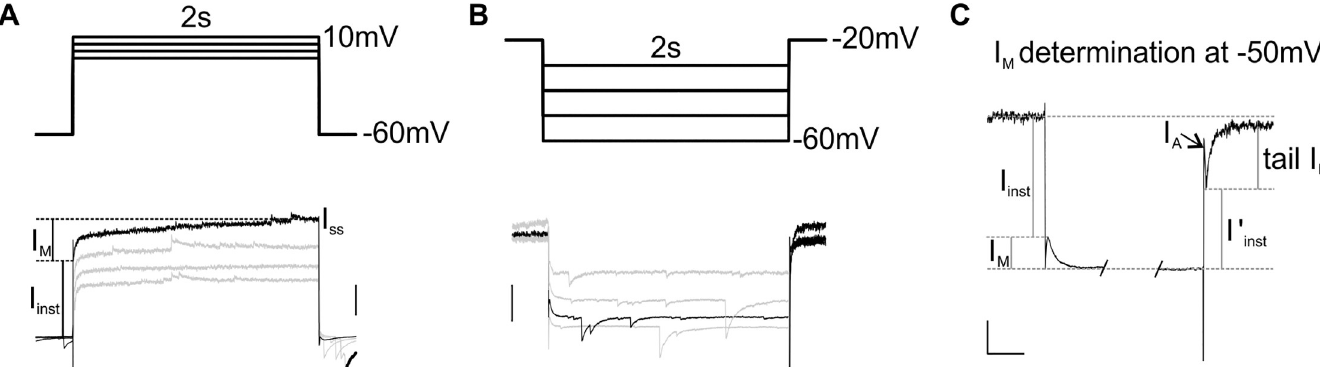
Fig 1. Presence of I M in SBCs. (A) Activation protocol (upper part) and its current response (lower part); scale: 500 pA. (B) Deactivation protocol (upper part) and its current response (lower part); scale: 200 pA. (C) Higher magnification of the current response shown in B at voltage step -50 mV; scale: 100 ms/100 pA.